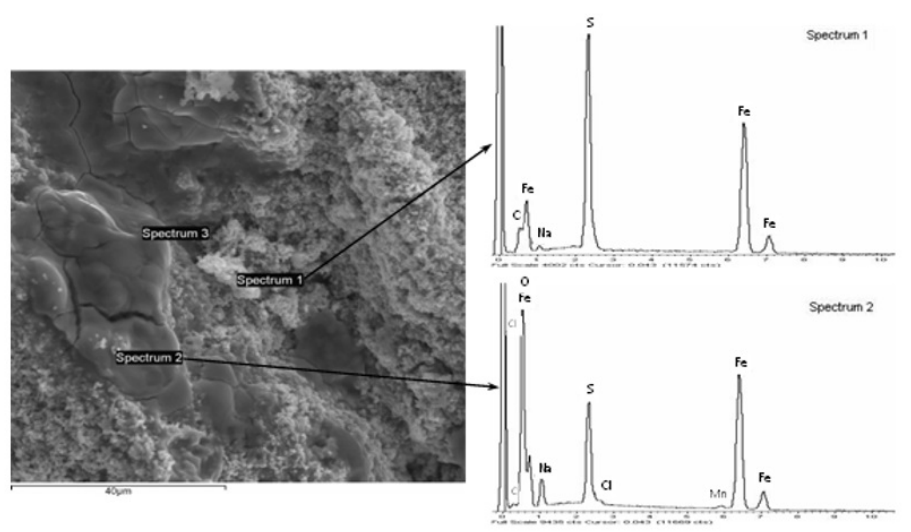
Figure 11. SEM and EDS characterization of the corrosion product film of the welded joint that was tested in solution 1 with pH=3.0.